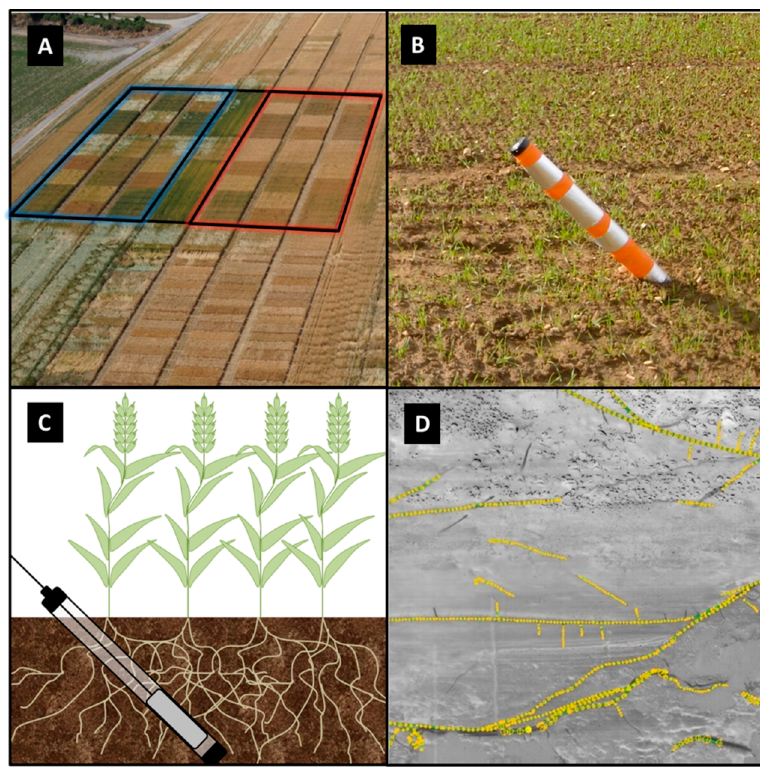
Figure 1. Illustration of in situ root measurements process. ( A ) Picture of the experimental field after anthesis. Irrigated plots are highlighted in blue, and rainfed plots are highlighted in red. ( B ) Picture of a minirhizotron installed after emergence. Covering thermal insulation material is maintained on the tube by orange tape. ( C ) Diagram of the minirhizotron principle. The clear plastic tube is inserted at a 45° angle, and root impacts on the tube are captured by a rotary scanner. ( D ) Screenshot of in-progress semi-automatic detection of root on captured images using Smartroot.